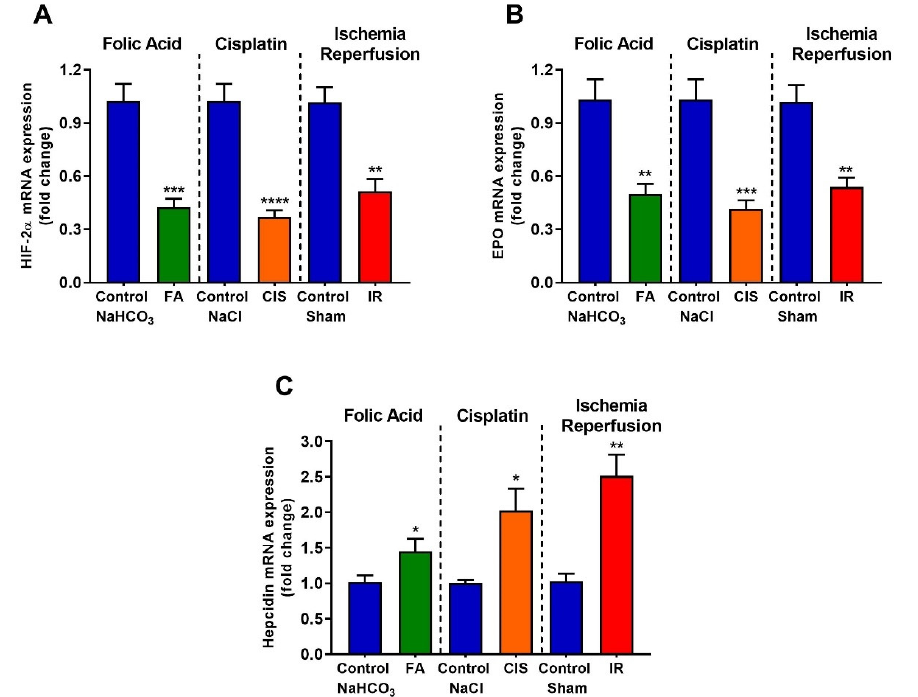
Figure 6. Effects of CKD on mRNA expression of genes related to red blood cell production and iron regulation. Renal mRNA expression of HIF-2 α ( A ), EPO ( B ), and Hepcidin ( C ) after folic acid (FA) treatment, cisplatin (CIS) treatment, and ischemia reperfusion (IR) surgery. Data presented as mean ± SEM; n = 6. Two-tailed Student ´ s t-test. * p < 0.05; ** p < 0.01; *** p < 0.001; **** p < 0.0001.